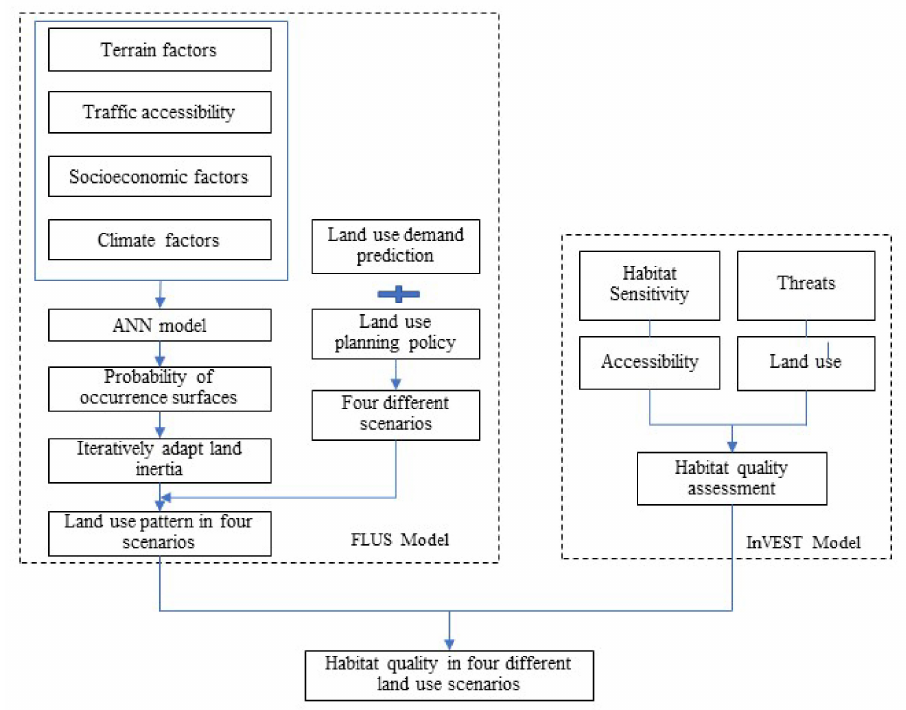
Figure 3. The research framework of FLUS- InVEST